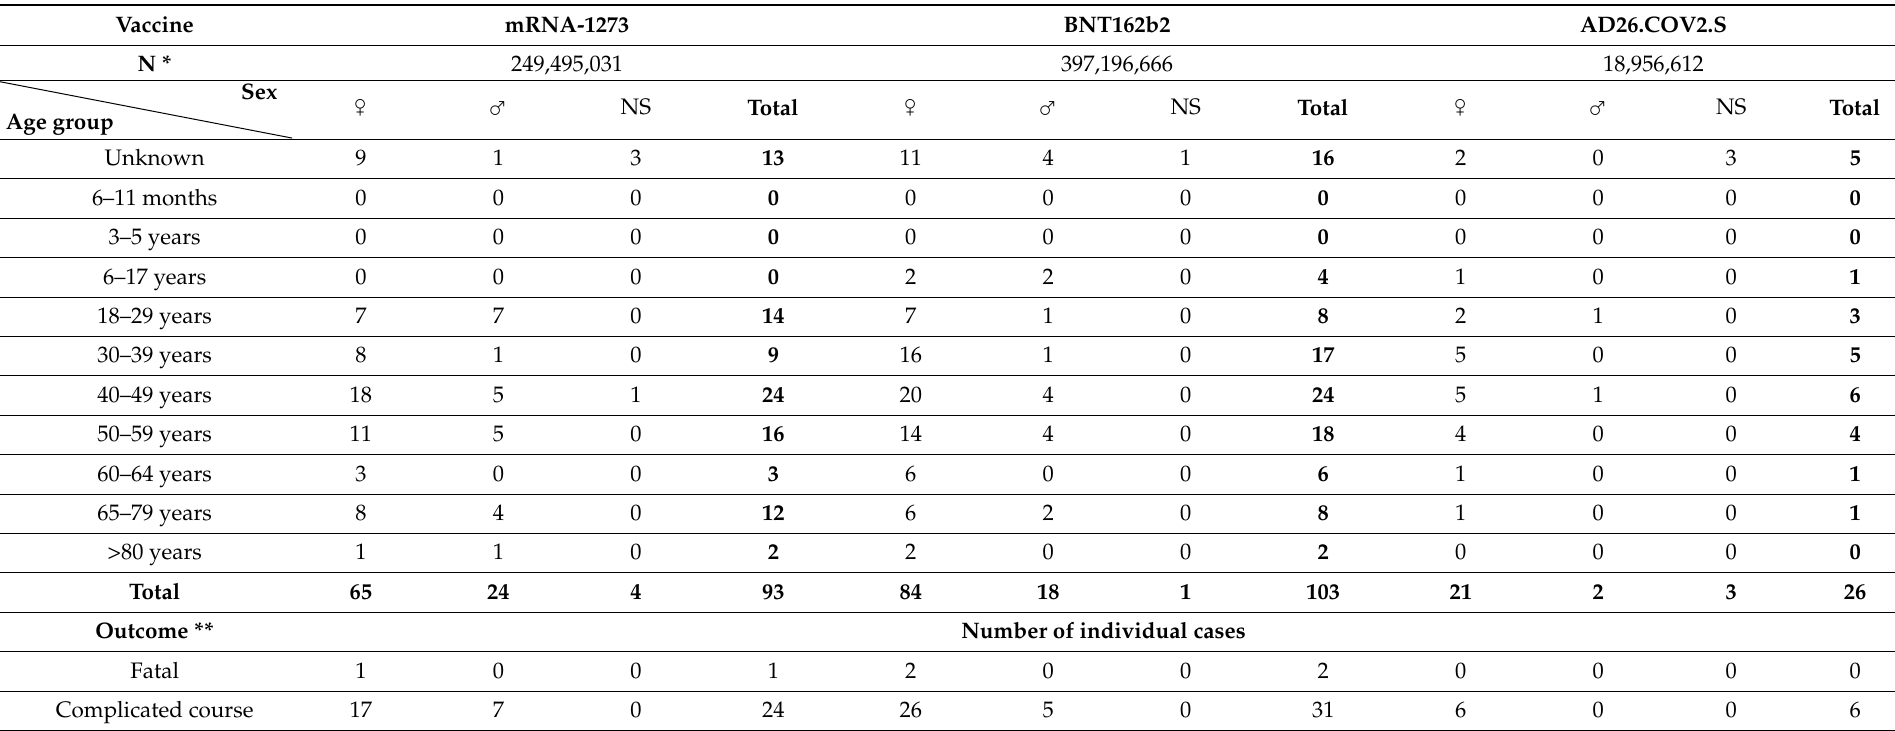
Table 4. Description of anaphylactic shock cases post-COVID-19-vaccination reported by the VAERS from week 52, 2020 to week 1,